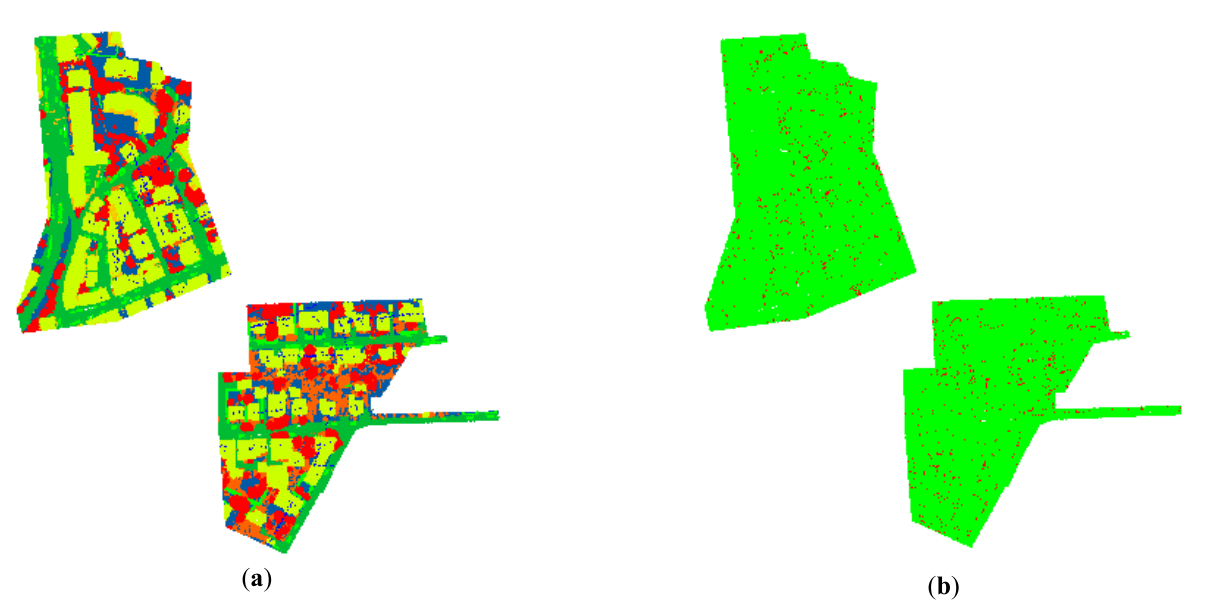
Figure 6. ( a ) Classification results of the Vaihingen urban 3D semantic dataset; ( b ) error